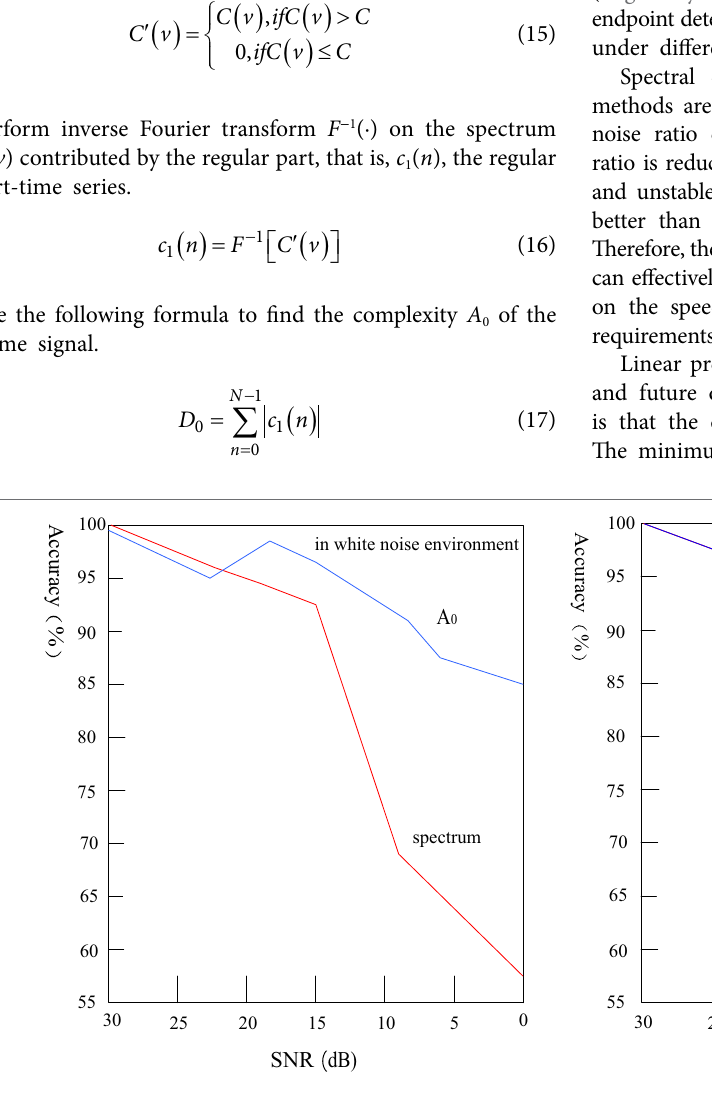
FIGURE 4 | Comparison of voice endpoint detection